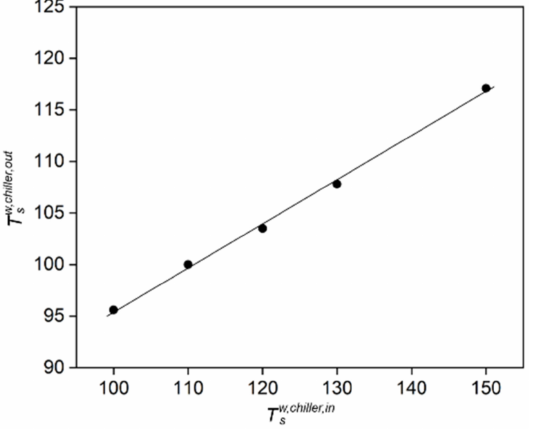
Figure 2. The relationship between T w , chiller , in s and T w , chiller , out s